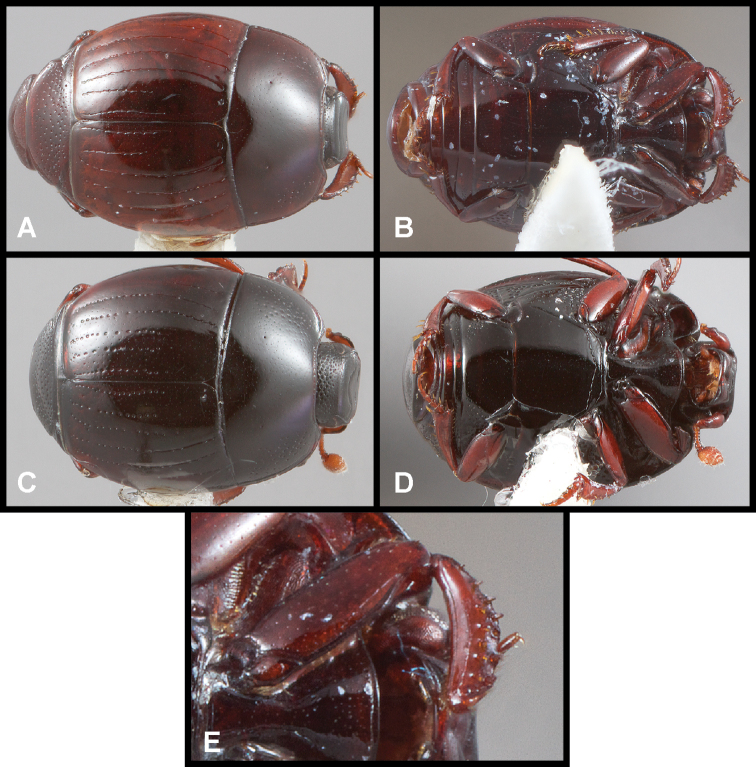
A, BPhelister
curvipes: A dorsal habitus B ventral habitus C–EP.
vilavelha: C dorsal habitus D ventral habitus E prothoracic leg, showing curved protibia.